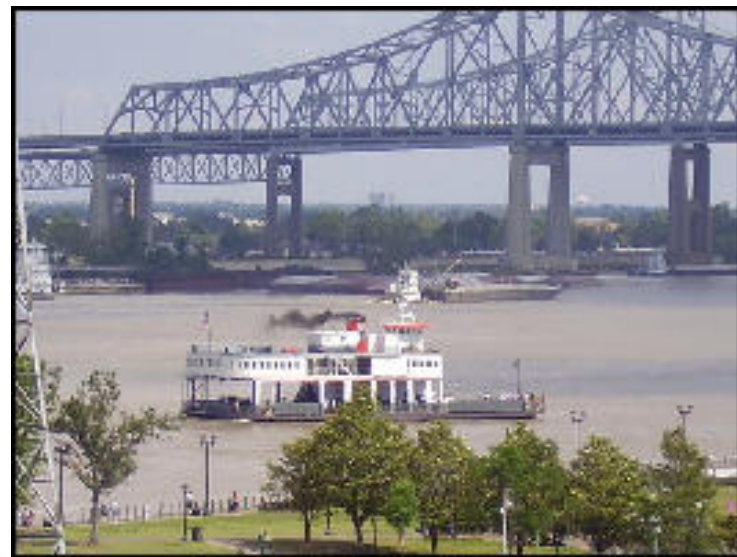
Figure 5. Canal Street Ferry